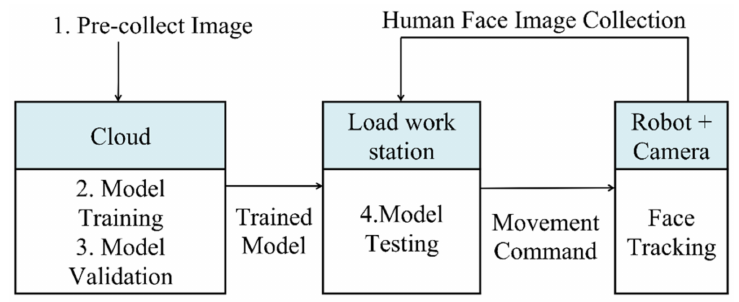
Figure 2. Deep learning architecture of face recognition and tracking.